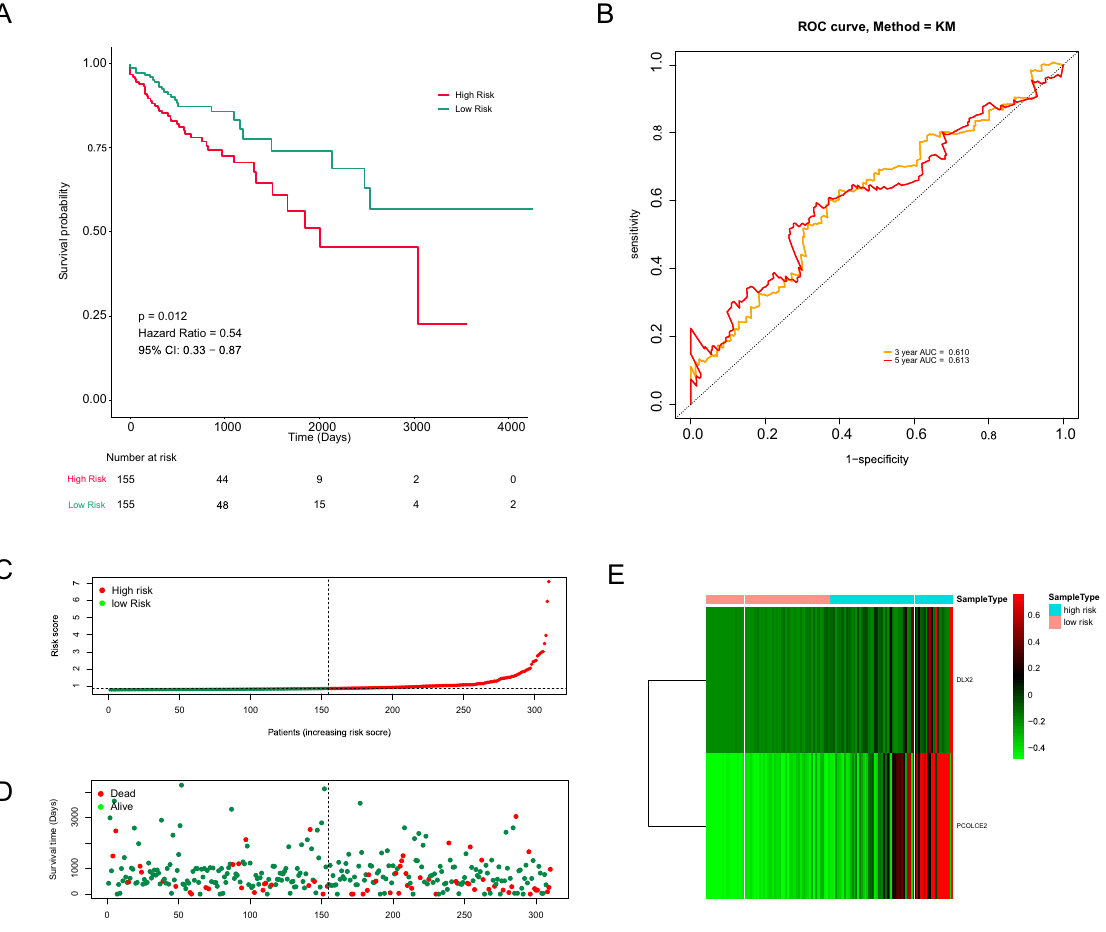
Figure 3. Combined DLX2 and PCOLCE2 genes in CRC overall survival prediction. ( A ) Kaplan–Meier survival curve of CRC patients between the low-risk group and the high-risk group. ( B ) 3- and 5-year ROC curve. ( C , D ) Risk score and survival status of the high-risk and low-risk groups. ( E ) The heat map of expression profile of the 2 prognostic genes. (software: pheatmap package in R, version number: 0.7.7, RUL link: https:// cran.r- proje ct. org/ src/ contr ib/ Archi ve/ pheat